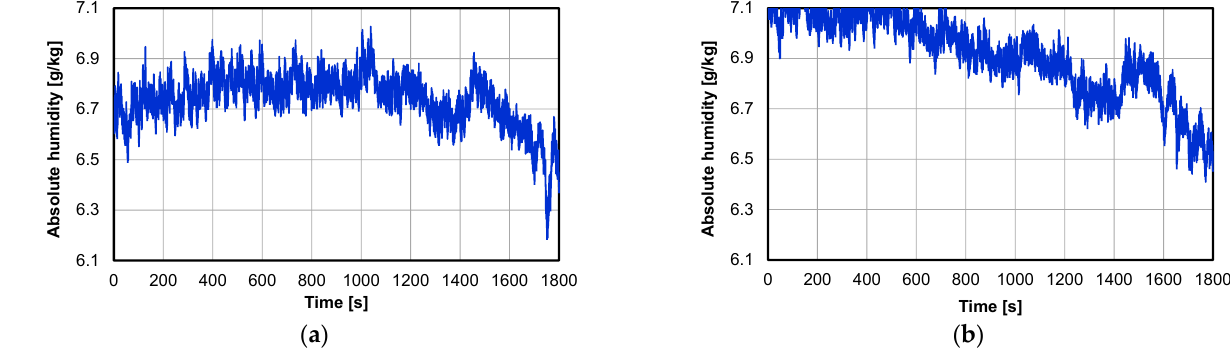
Figure 6. The absolute humidity versus time for: ( a ) plug-in; ( b ) HEV. The relative humidity during the tests is shown in Figure 8a for the plug-in and in Figure 8b for HEV. The relative humidity in the case of the plug-in was lower by 1–3% compared to that in the case of HEV. Such differences were higher for the lower velocities during the WLTC tests. It also resulted from conditions in the place where the dyno was